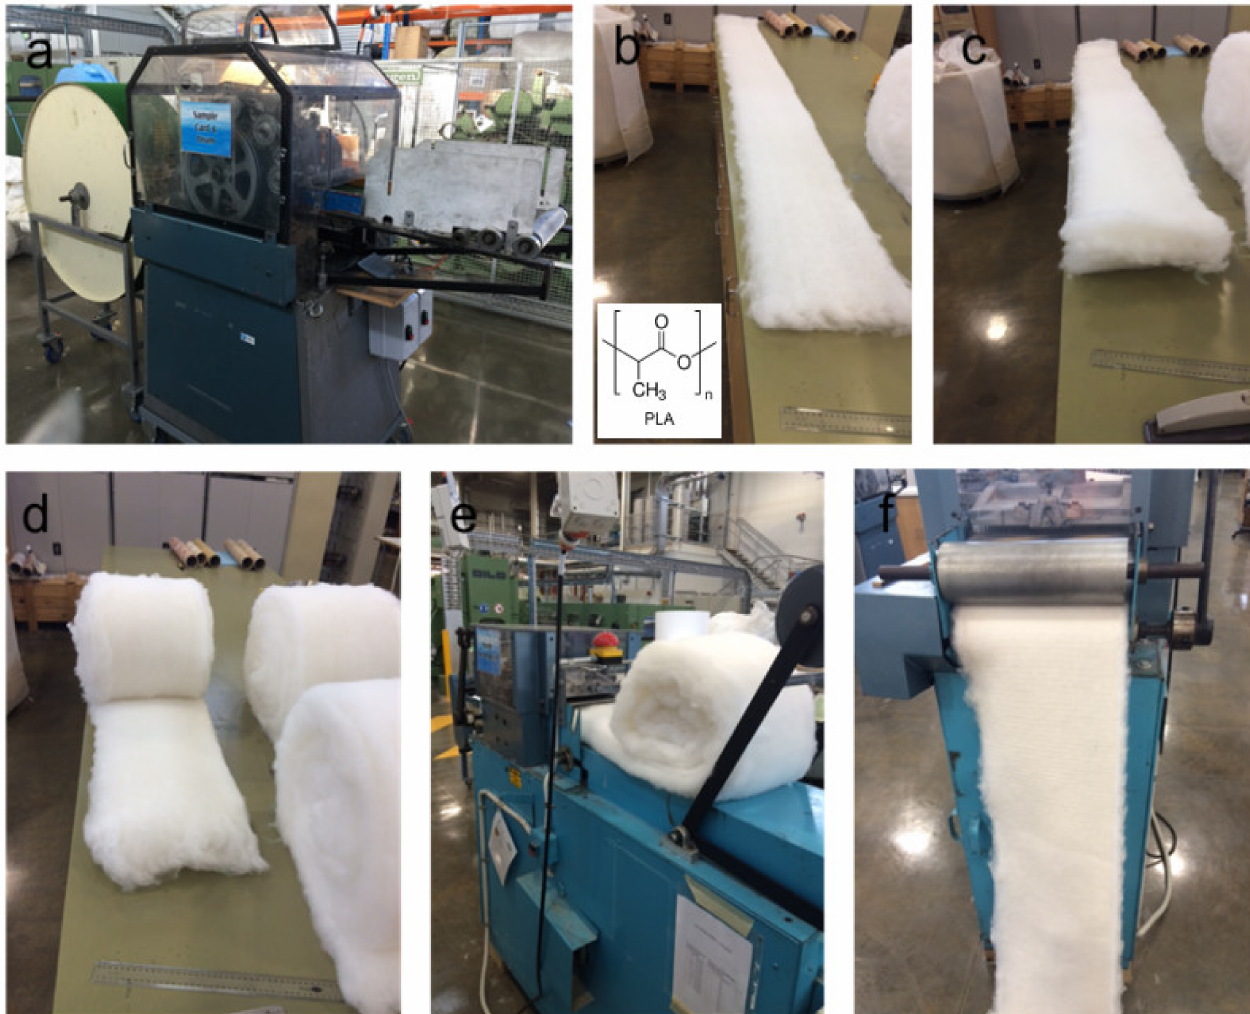
Figure 1. Processing nonwoven mats from cotton and PLA fibres. ( a ) Carding machine; ( b ) equivalent weight of cotton fibres and PLA fibres were hand blended firstly before putting through a carding machine twice for uniform mixing; ( c , d ) webs were then stacked into multiple layers; ( e ) 12 layers of webs went through needle punching machine at 30 punches/cm 2 on both sides; ( f ) nonwoven mats for the manufacture of composite